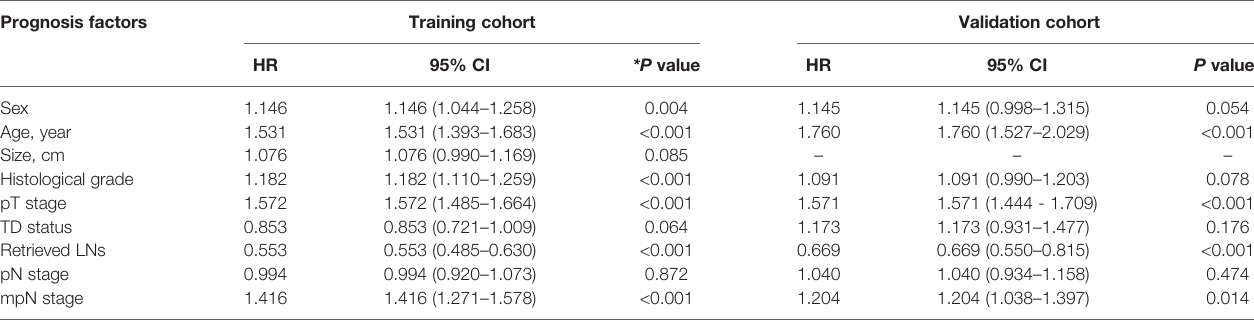
TABLE 6 | Multivariate survival analysis of patients with colorectal cancer after including mpN stage in the training and validation cohorts. Prognosis factors Training cohort Validation cohort HR 95% CI *P value HR 95%